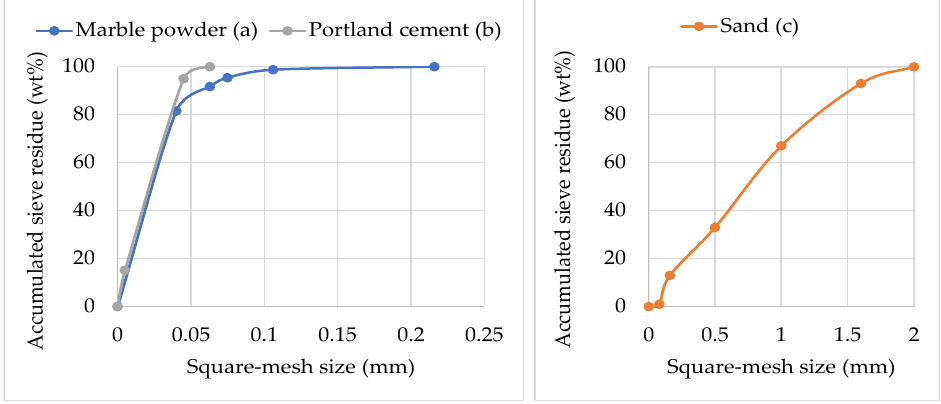
Figure 3. Particle-size distribution of ( a ) Marble powder, ( b ) Portland cement, and ( c ) Normalized sand, according to EN 196-1 [53].